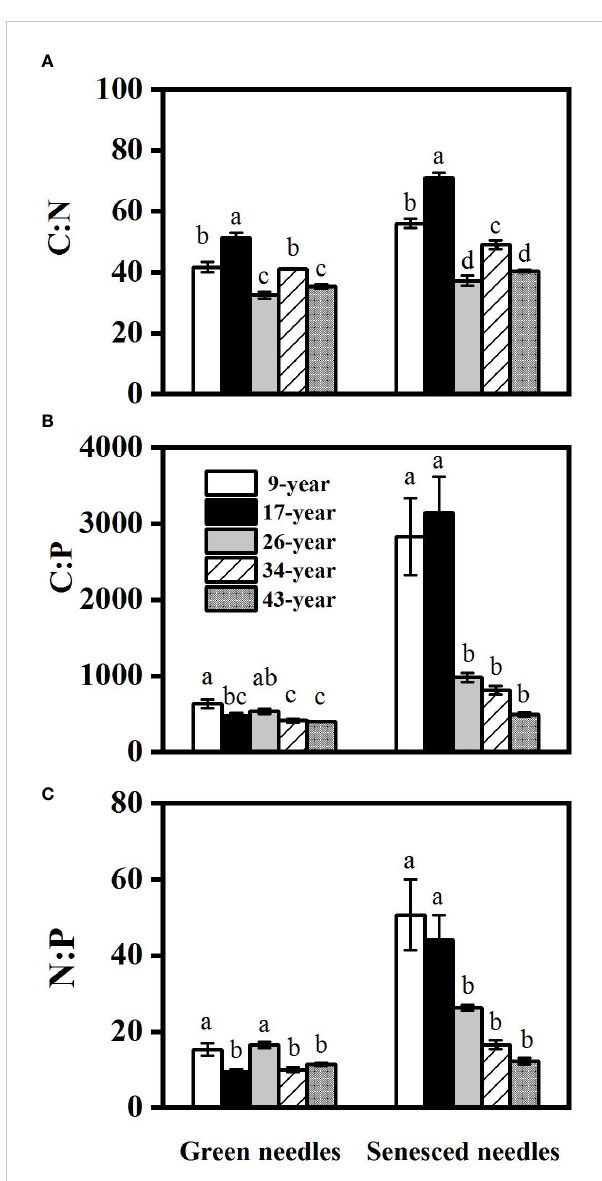
FIGURE 3 Changes in needle C:N (A) , C:P (B) and N:P (C) in Pinus massoniana plantations with different stand ages. Different lowercase letters indicated signi fi cant differences among the stand ages for each needle type ( p